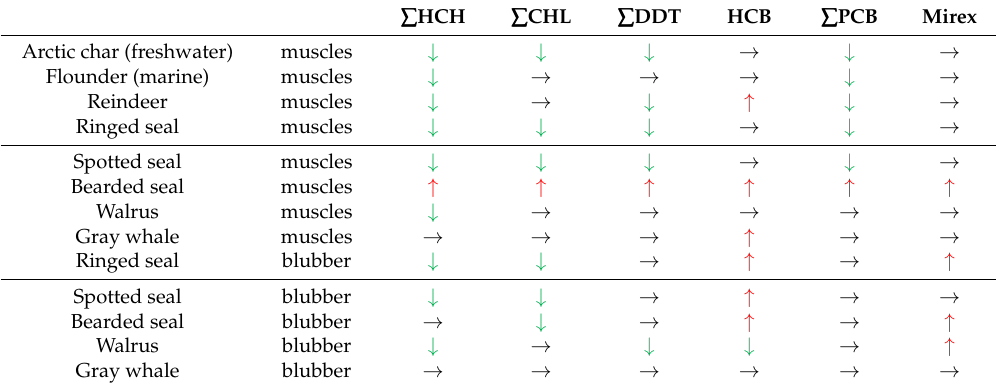
Green arrows down = decrease; black arrows flat = no change; red arrows up =